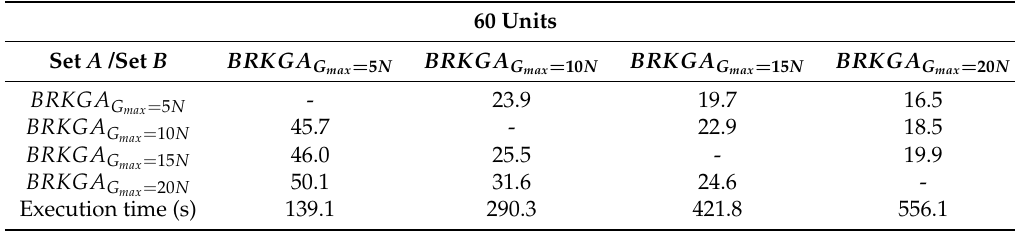
Table 6. Percentage of Non-dominated Solutions of set B covered by those in set A for case study 1 with pc = 0.7 and N p = 2 N